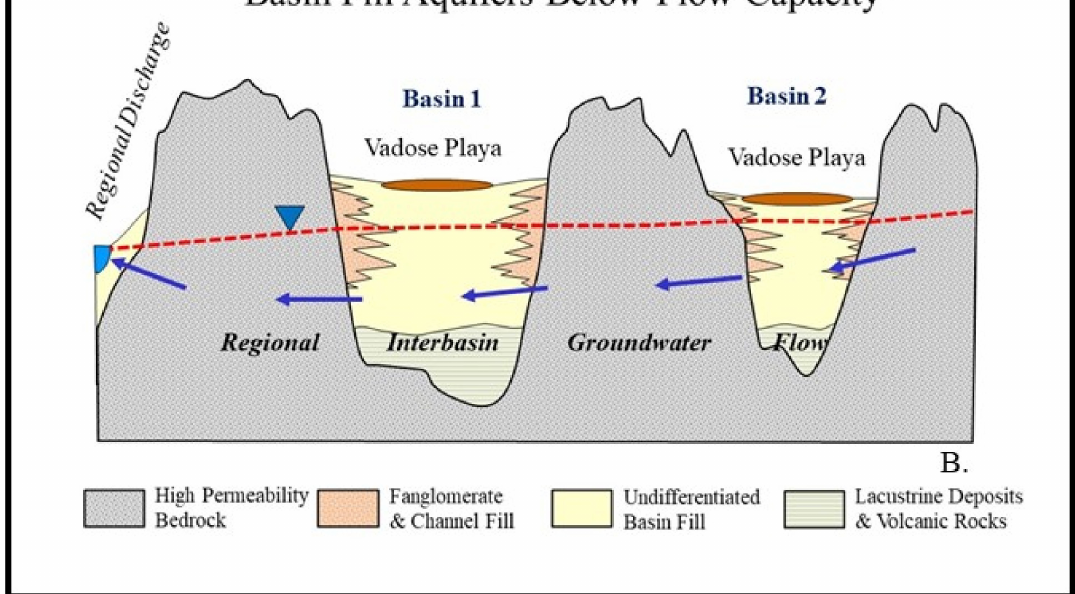
Figure 3. Conceptual diagram showing interconnected basins at flow capacity and non-capacity. Topographically closed and partly drained basins ( A ) and topographically closed and fully drained basins ( B ) are shown. Flow systems with basin floors at flow capacity usually have a phreatic (wet) playa at the basin floor. Regional flow paths may change as basin aquifer systems transition from flow capacity to non-capacity. The surface elevation of the phreatic playas in model ( A ) regulates hydraulic head and regional groundwater